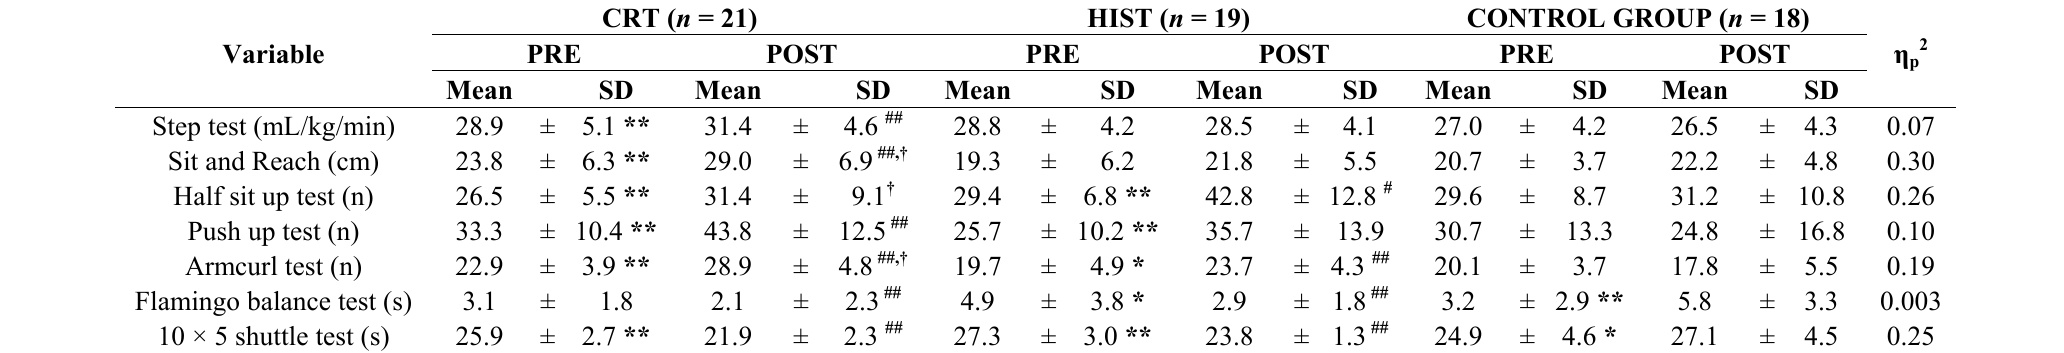
Table 3. Descriptive statistics (Mean ± SD) of fitness level